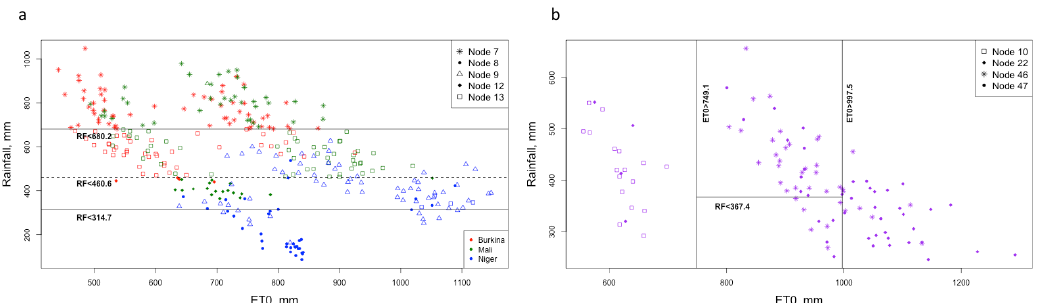
Figure 10. ( a ) The regression tree for Burkina Faso, Mali, and Niger plots ET 0 against precipitation. The rules for Burkina Faso and Mali have the first rule of precipitation greater (less) than 680.2 mm and the second rule of precipitation greater (less) than 460.6. The rule for Niger has precipitation greater (less) than 314.7 mm. ( b ) The regression tree for Senegal plots ET 0 against precipitation. The first rule is ET 0 greater (less) than 749.1 mm. The second rule is ET 0 greater (less) than 997.5 mm. The final rule is precipitation greater (less) than 367.4 mm.